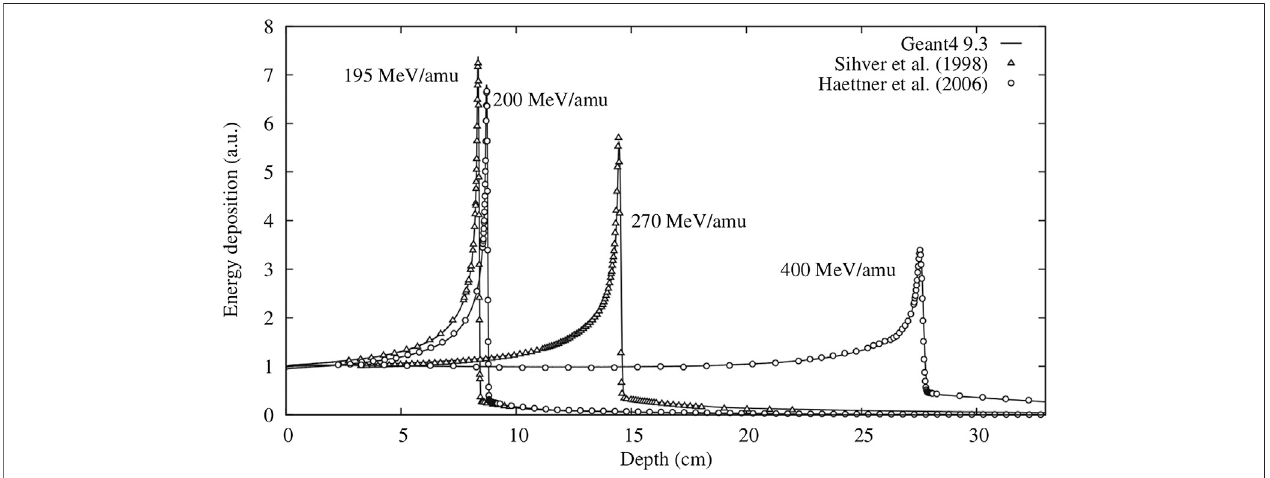
FIGURE 1 | From Lechner et al. [66]: an example of an excellent agreement between data and GEANT4 MC simulations in predicting the depth – dose pro fi le of carbon ion beams.